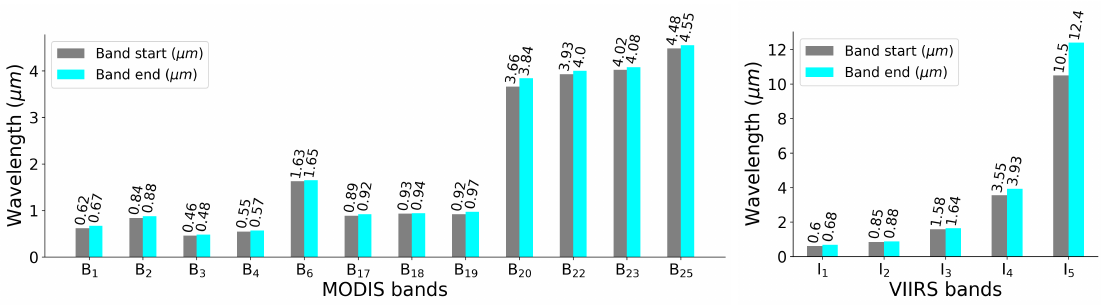
Figure 3. Spectral range of MODIS ( left ) and VIIRS ( right ) bands used in our analysis. The start and end wavelengths are shown for each band.